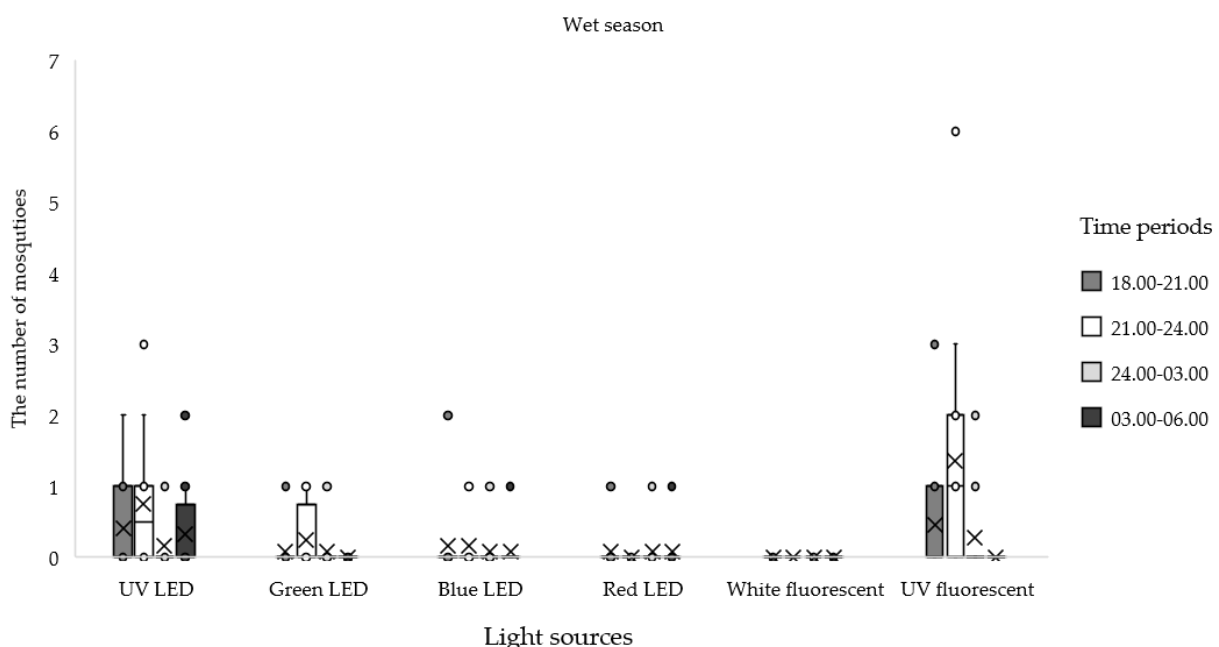
Figure 2. Mean numbers of Anopheles mosquitoes caught at different times of night by using different light traps during the dry season, February to May 2020.